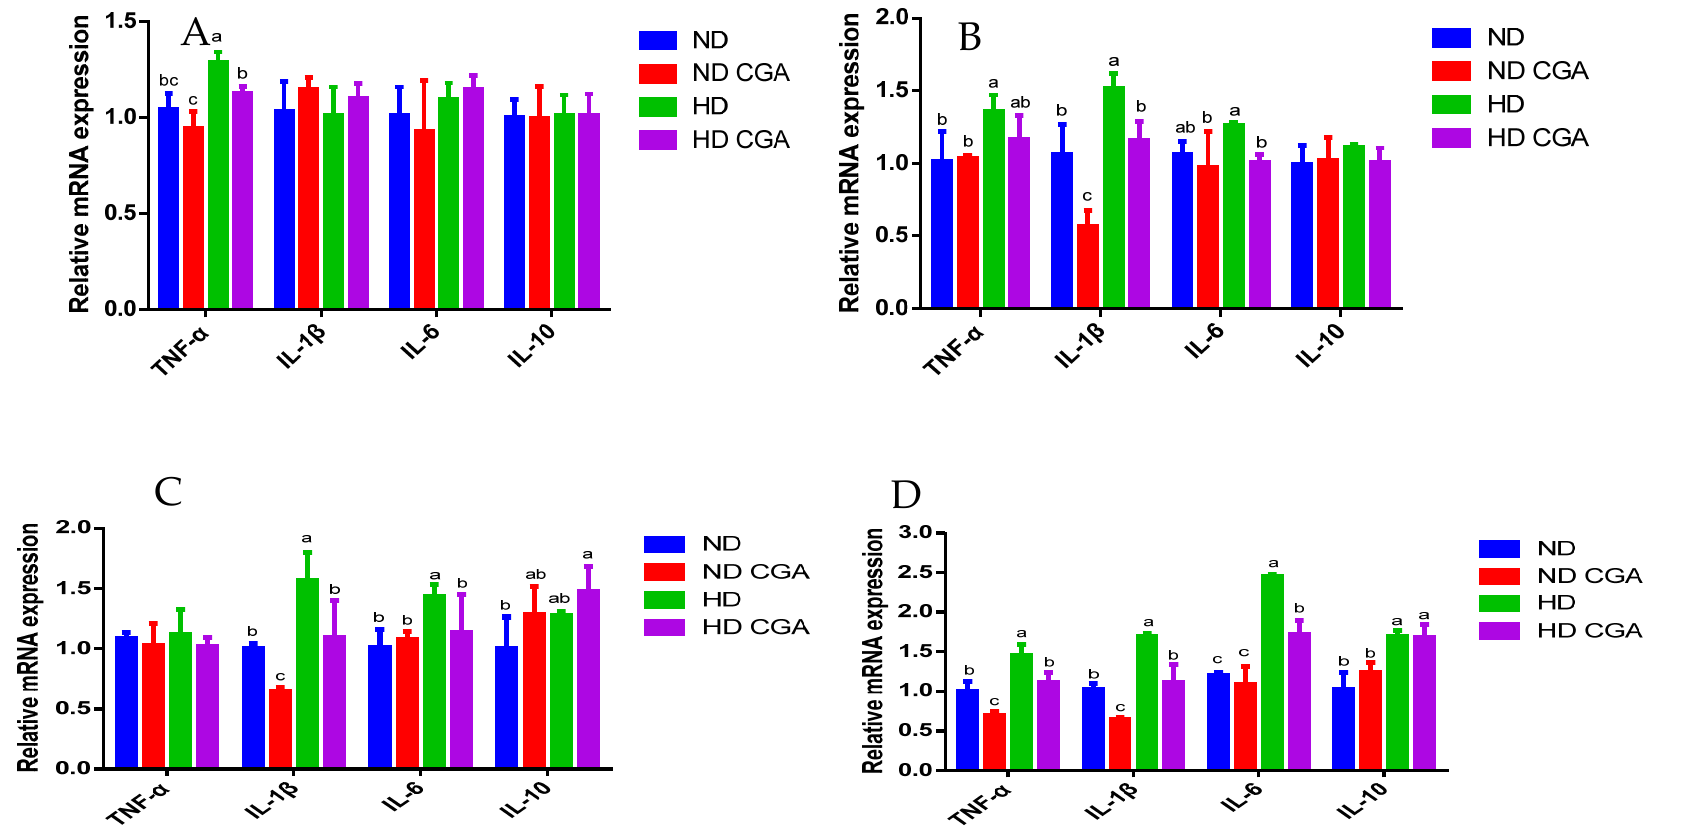
Figure 4. Effects of CGA on jejunal mRNA expression of immune factors in broilers under HD stress. ND group, normal stocking density + basal diet; ND + CGA group, normal stocking density + basal diet + 0.15% CGA; HD group, high stocking density + basal diet; HD + CGA group, high stocking density + basal diet + 0.15% CGA. ( A ) Relative mRNA expression at day 21. ( B ) Relative mRNA expression at day 28. ( C ) Relative mRNA expression at day 35. ( D ) Relative mRNA expression at day 42. Each vertical bar represents the mean ± SEM (n = 10). Values with different letters are significantly different ( p < 0.05, Tukey’s HSD test after one-way ANOVA).